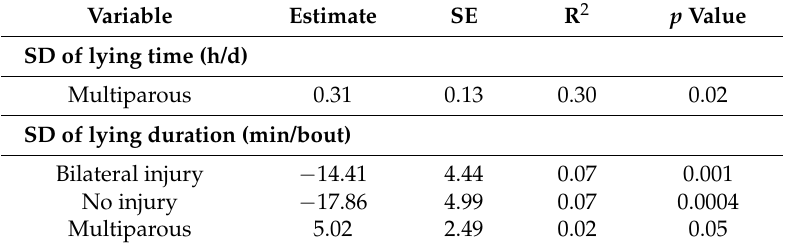
Table 2. Standard deviation of the herd average daily lying time (h/d) and lying bout duration (min/bout) with parity and hock injury status. Standard deviation of lying time and lying bout duration increased with multiple parities. Standard deviation of lying bout duration decreased when both hocks were injured or not